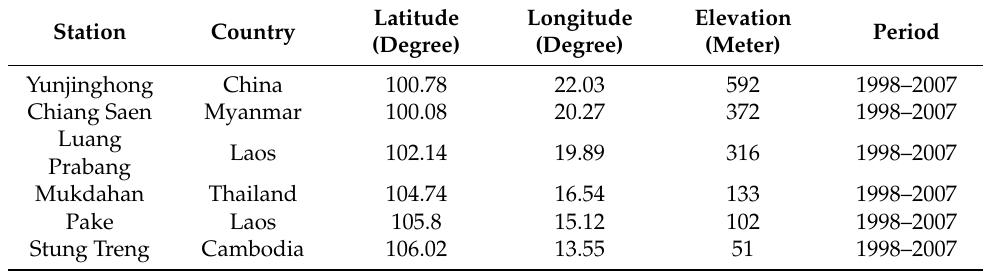
Table 2. Basic information on the six hydrological stations used in this study.